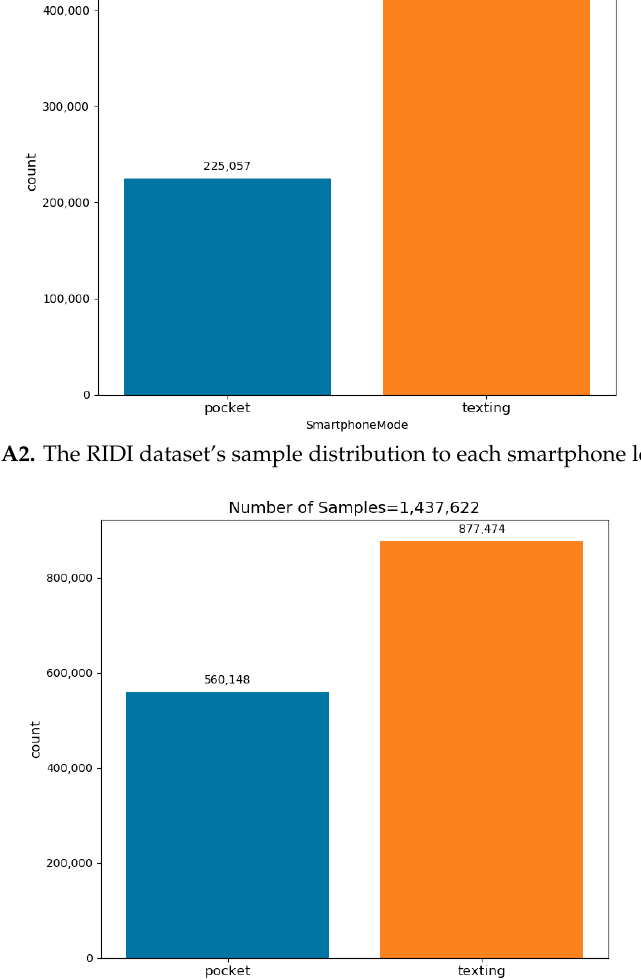
Figure A3. The OXF dataset’s sample distribution to each smartphone location.